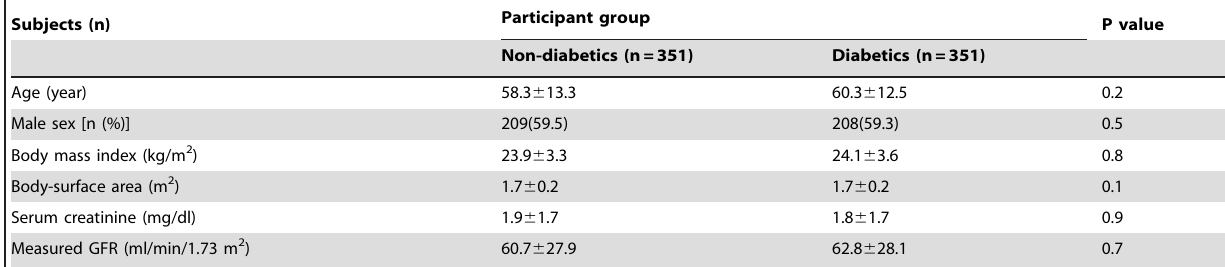
Table 2. Participant characteristic.*